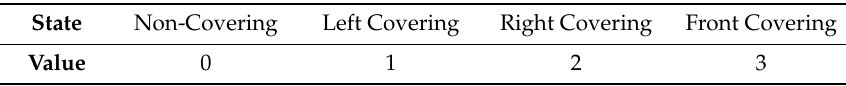
Table 3. Language conversion of feature types